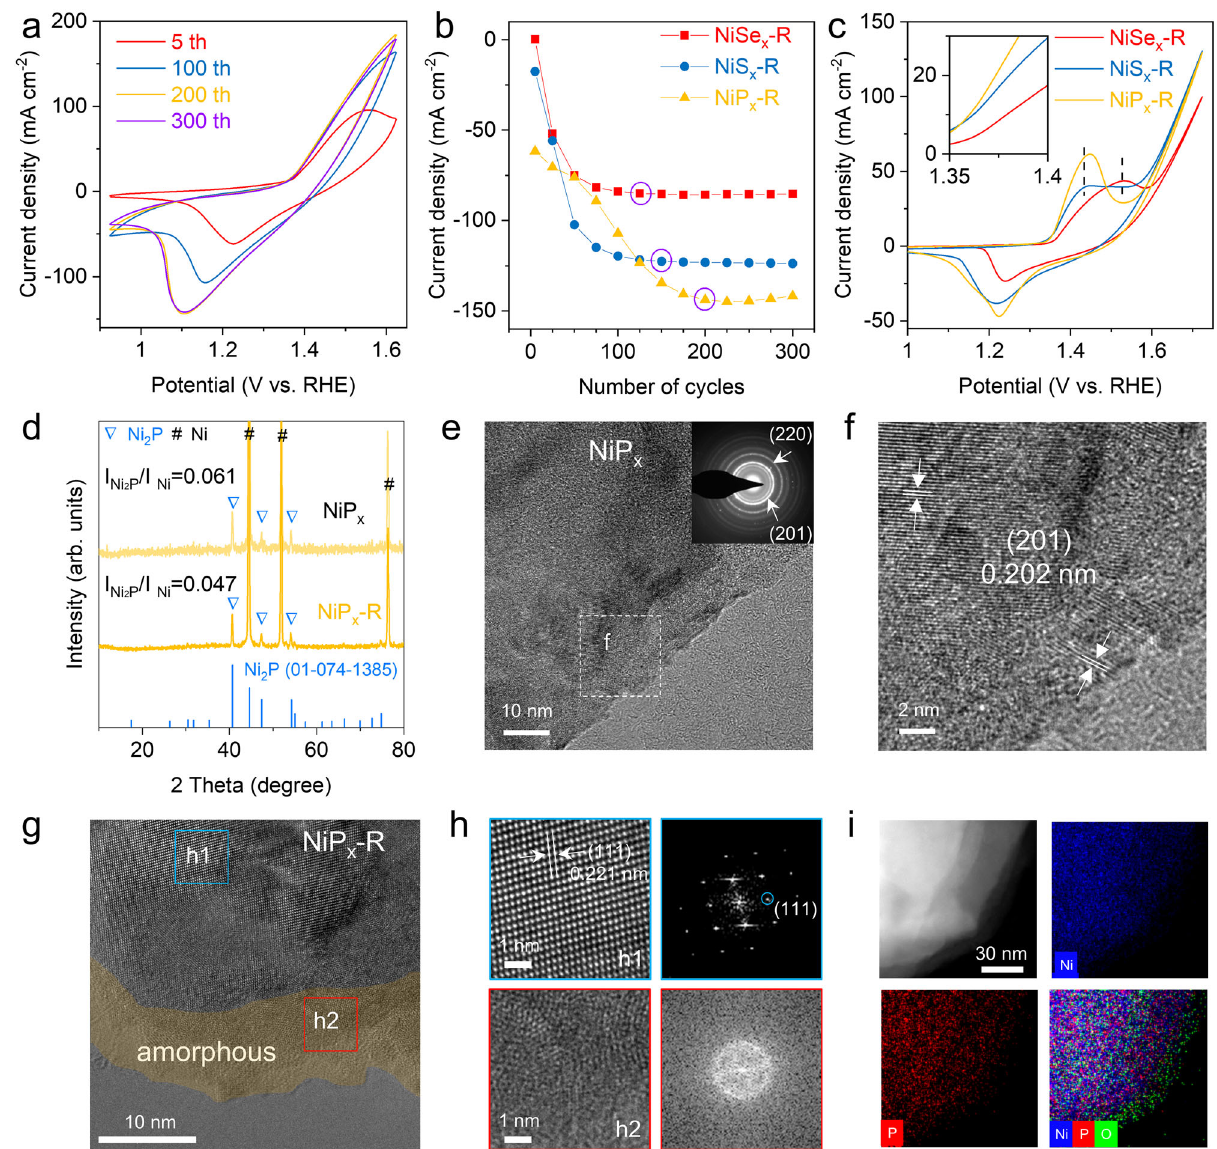
Fig. 2 Activation preparation, structure, and morphology characterizations of NiP x -R. a Evolution of CV curves for NiP x from the 5th to the 300th cycle in 1 M KOH at 100 mV s − 1 . b Cathodic peak current (I pc ) as a function of cycle number. c CV curves for NiP x -R, NiS x -R, and NiSe x -R in 1 M KOH at 100 mV s − 1 . d XRD patterns for NiP x and NiP x -R. e TEM image with SAED pattern (inset), and f corresponding HRTEM image of NiP x . g , h HRTEM images and the corresponding FFT patterns of the selected regions marked by the blue and red squares in ( g ). i HADDF-STEM image and corresponding elemental mappings of NiP x